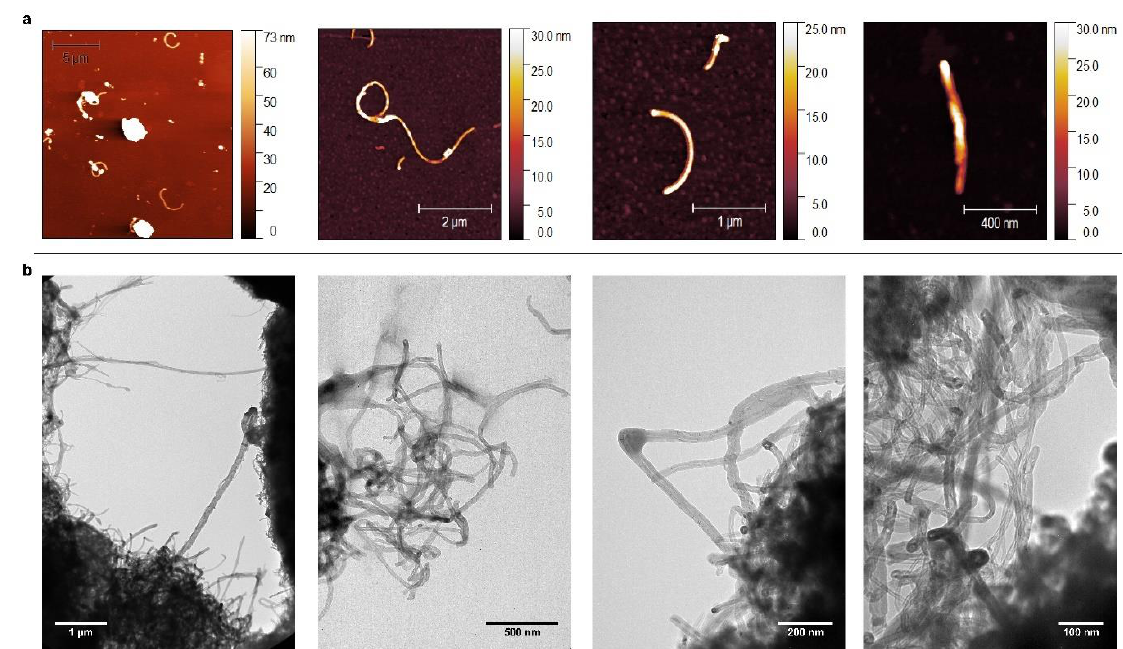
Figure 1. AFM ( a ) and TEM ( b ) images of NTX1 MWCNTs. Samples dispersions with a concentration of 20 mg L −1 were deposited by drop casting on a mica surface and carbon-coated copper grids, respectively.